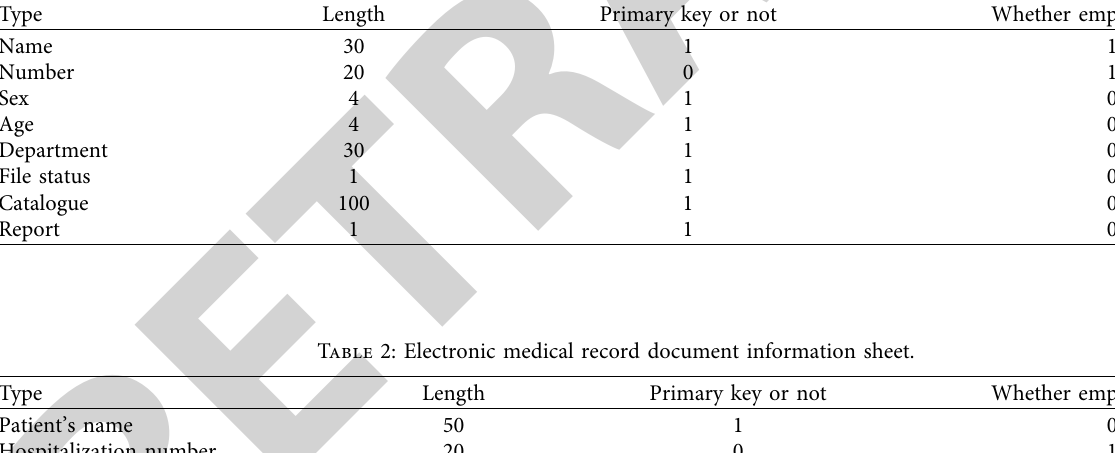
Figure 6: Intelligent file management. Table 1: Basic information of electronic medical records.